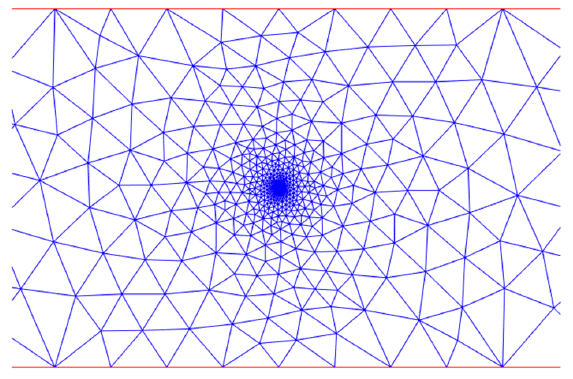
Figure 4. Example of a mesh created for the 2D Finite Element calculations presented in this work with a nanometer-sized precipitate in the center.